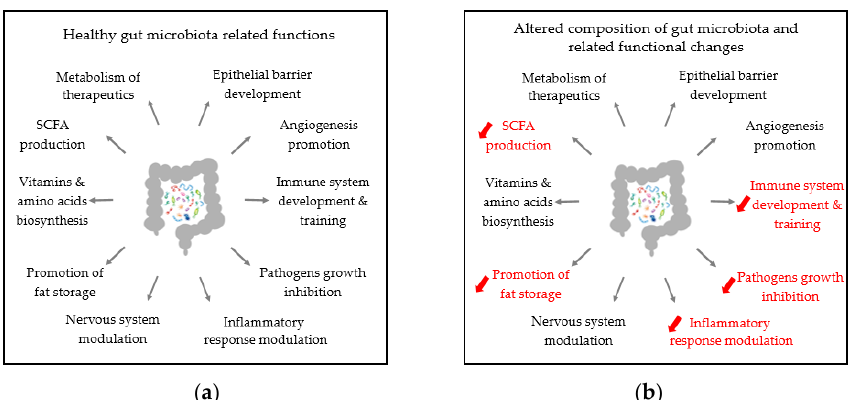
Figure 4. Microbiota functions affect different host systems [36]: ( a ) list of benefits derived by healthy gut microbiota functions; ( b ) examples of main negative consequences due to the altered composition of the gut microbiota partially due to lifestyle and habits factors.